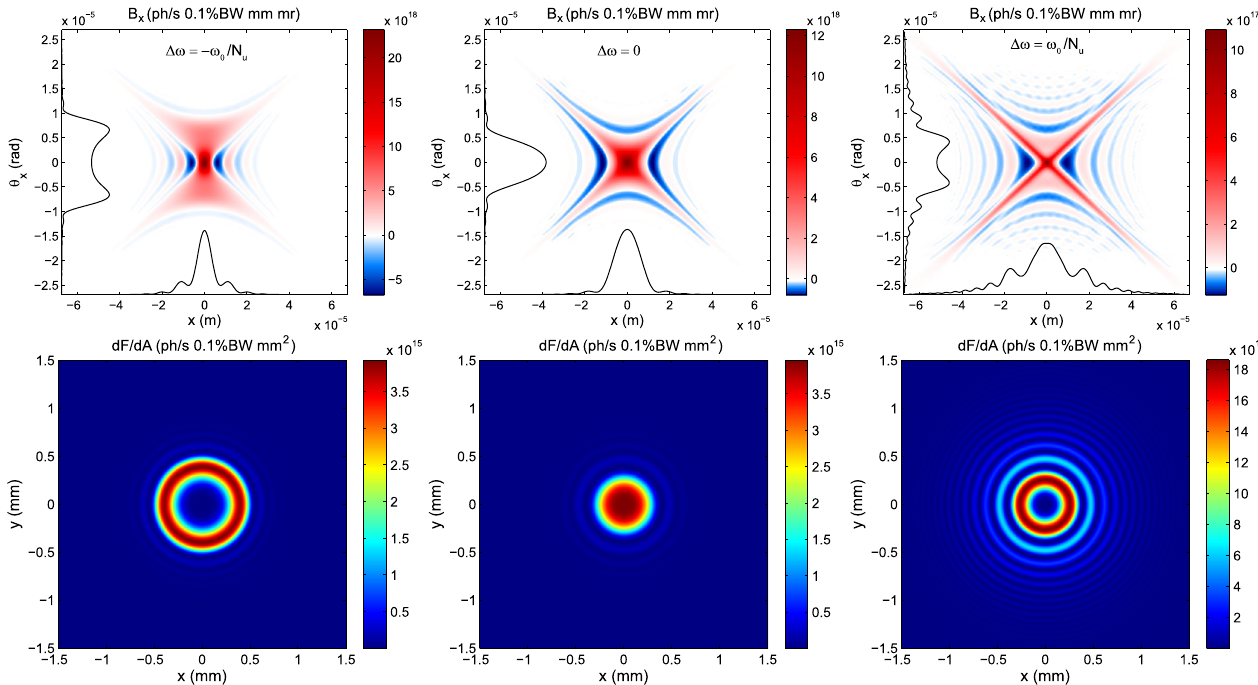
FIG. 16. The WDF (top row) corresponding to Fig. 15 for different detuning off the resonance. The WDF is backpropagated to the undulator center. Solid lines show position and angular intensity projections. The radiation pattern used to calculate WDF (bottom row) is obtained at 50 m from the undulator